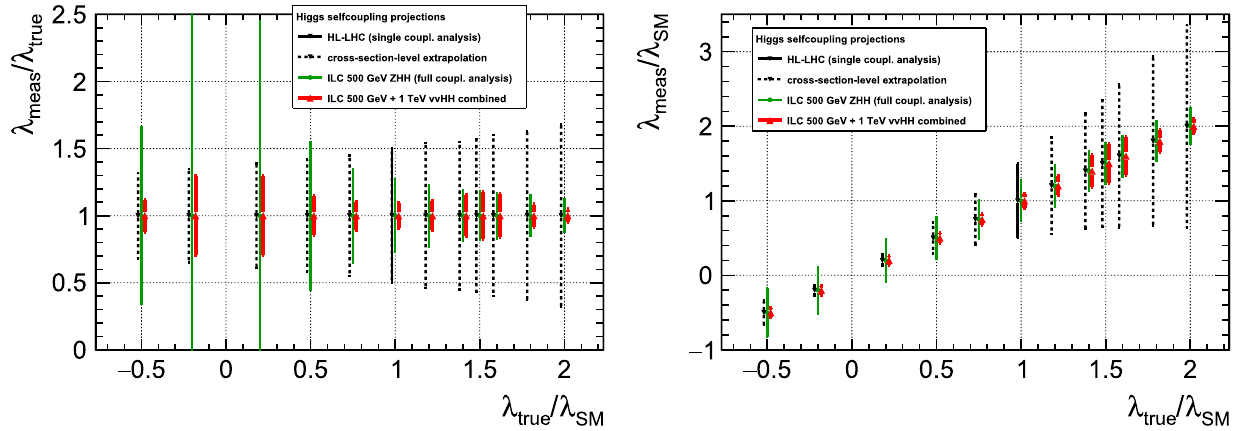
Fig. 3 Anticipated precision in the experimental determination of λ hhh as a function of λ hhh /λ SM